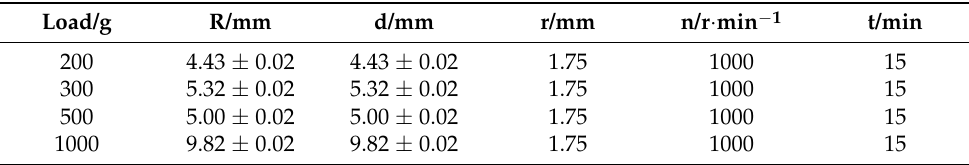
Table 5. Wear rate parameters under different loads.